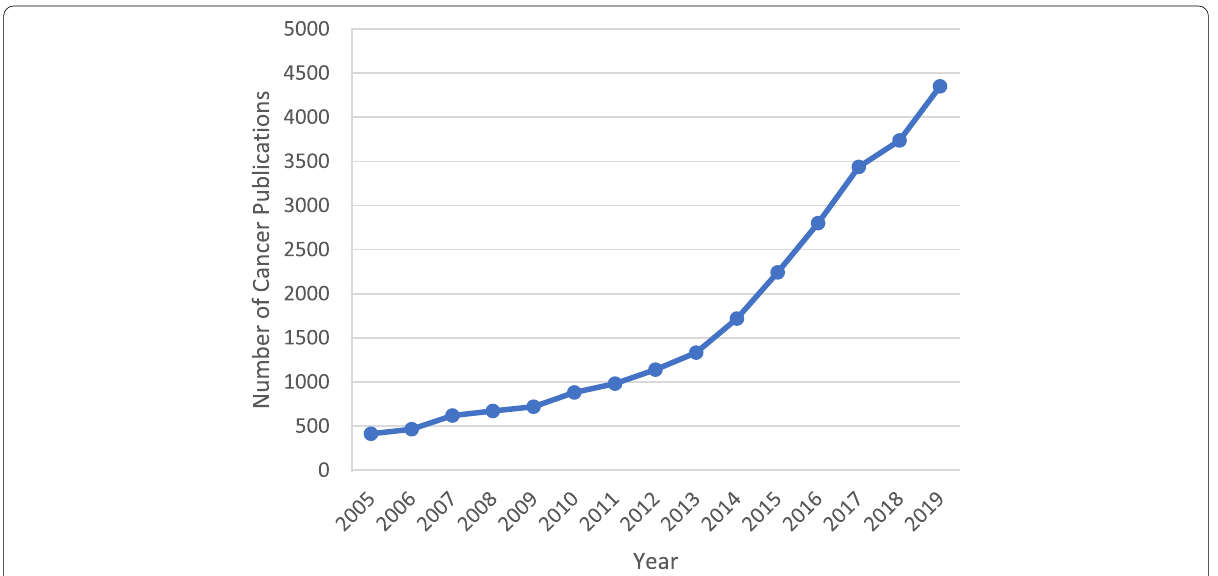
Fig. 2 Line graph showing the number of total cancer-related publications in the Arab world each